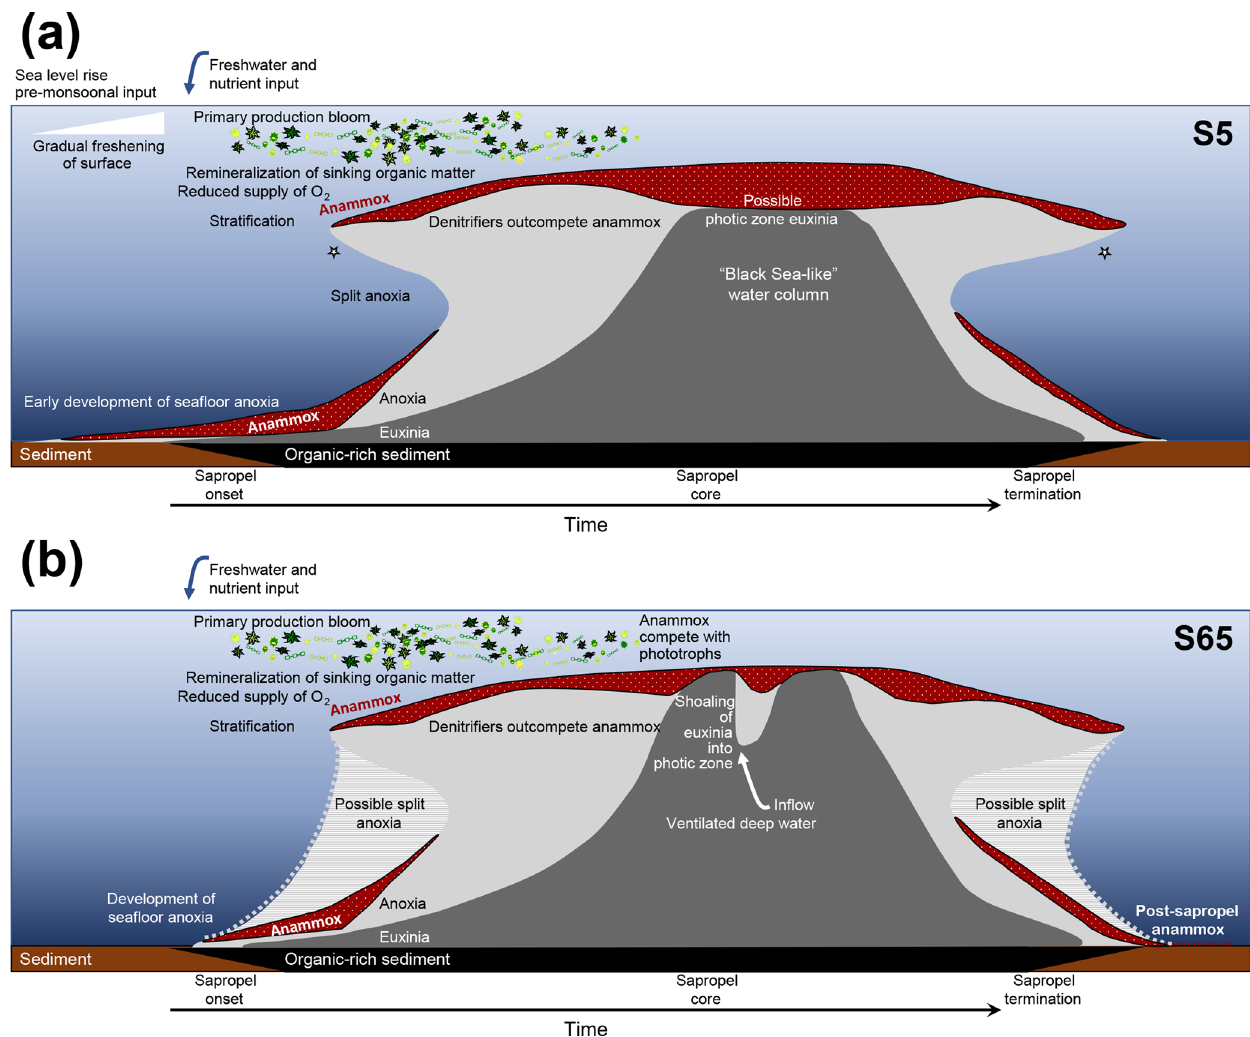
Figure 5. Hypothesised temporal evolution of anammox in the Levantine Basin water column during sapropel formations. (a) Scenario of S5; (b) scenario of Pliocene S65. Depth not to scale. Proposed niches for anammox bacteria are shaded in dotted red. Light grey area represents water column anoxia; dark grey is euxinia. Stars denote periods when short-chain ladderanes were formed by β oxidation in the oxic water column. Figure should be used as a guide for the